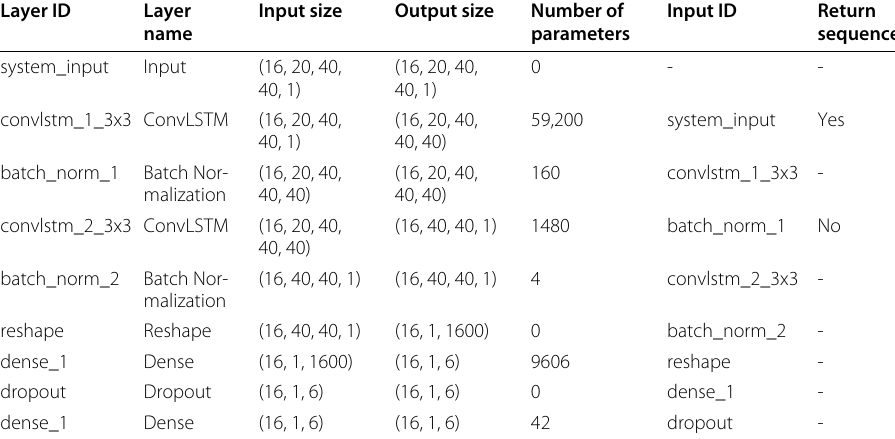
Table 2 ConvLSTM baseline architecture detailed